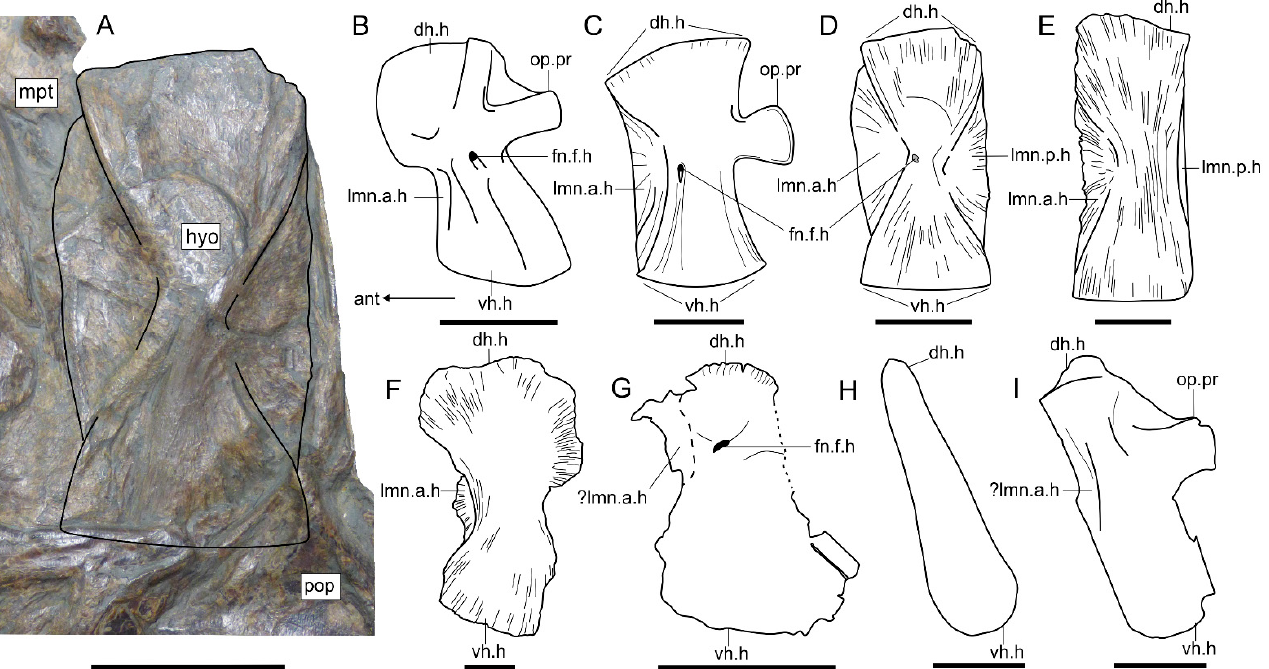
Figure 5. Comparative hyomandibular morphology in pachycormids: ( A ) left hyomandibula of SMNS 15815, Germanostomus pectopteri gen. et sp. nov., in lateral view; ( B ) Pachycormus macropterus (redrawn from Reference [27]); ( C ) Saurostomus esocinus (redrawn from Reference [24]); ( D ) Germanostomus pectopteri gen. et sp. nov., interpretive drawing of ( A ); ( E ) Ohmdenia multidentata , holotype (GPIT-PV-31531); ( F ) Leedsichthys problematicus , based on NHMUK PV P 1823 (mirrored); ( G ) Martillichthys renwickae , holotype (NHMUK PV P 61563, drawing based on Reference [20]); ( H ) Rhinconichthys sp. (redrawn from Reference [17]); ( I ) Bonnerichthys gladius , holotype (KUVP 60692, redrawn from Reference [5]). dh.h, dorsal head of the hyomandibula; fn.f.h, foramen for the facial nerve of the hyomandibula; hyo, hyomandibula; lmn.a.h, medial-anterior lamina of the hyomandibula; lmn.p.h, medial-posterior lamina for the hyomandibula; mpt, metapterygoid; op.pr, opercular process of the hyomandibula; pop, preopercle; vh.h, ventral head of the hyomandibula. Scale bars = 30 ( A – D ), 50 ( E , G – I ), and 100 mm ( F ).